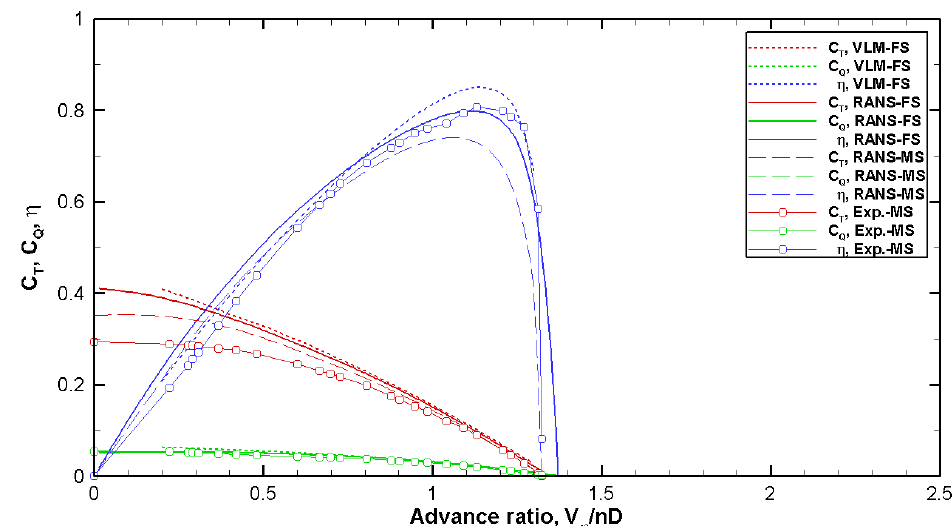
Figure 12. Propeller-performance curve for pitch angle = 29°.